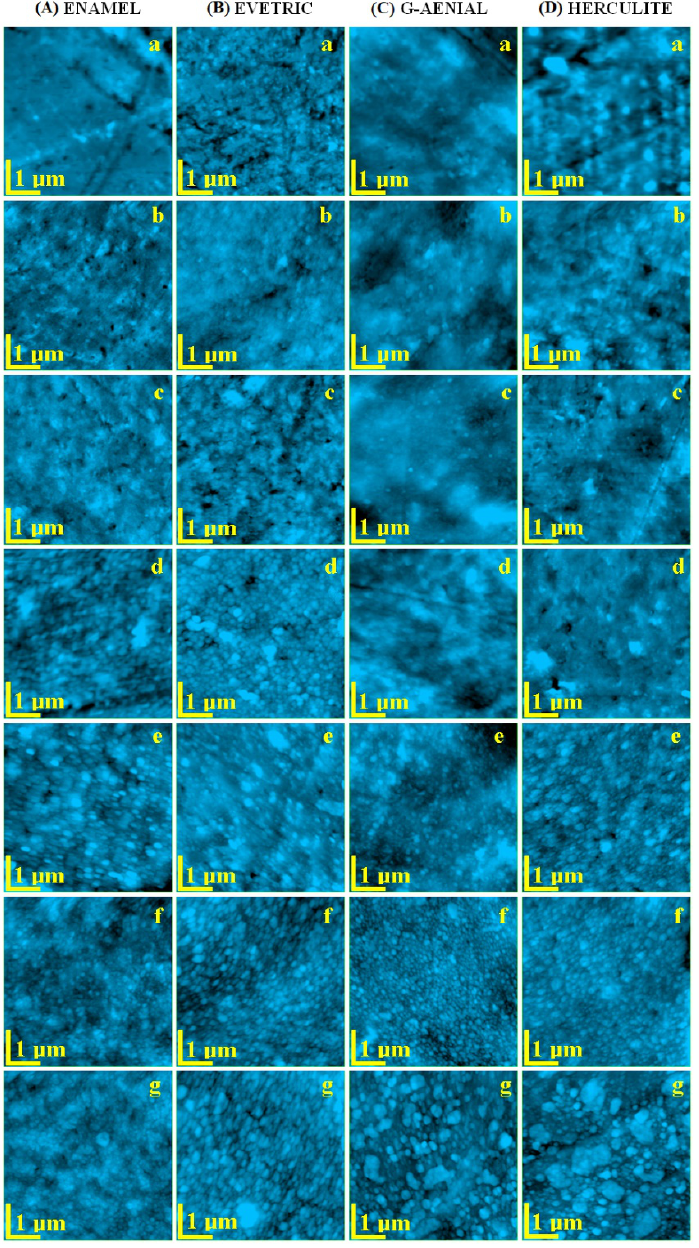
Figure 1. AFM topographical images for dental composites ( A ) Enamel, ( B ) Evetric, ( C ) G-aenial, and ( D ) Herculite exposed to various saliva: ( a ) untreated sample, ( b ) healthy, ( c ) artificial, ( d ) AML, ( e ) CML, ( f ) ALL, ( g ) CLL.